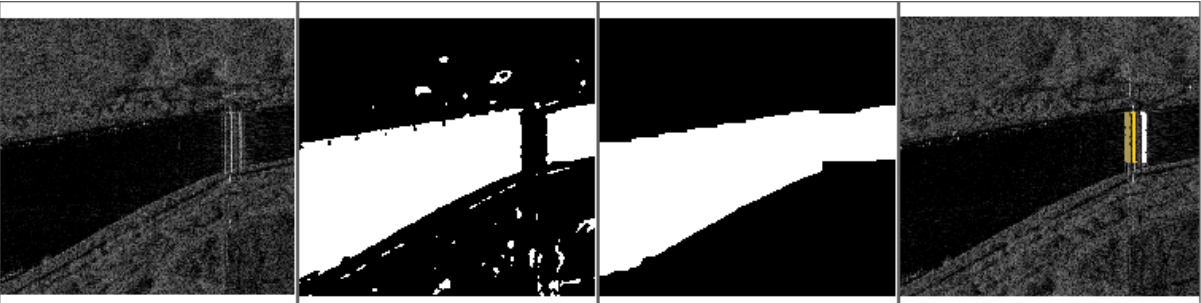
Figure 6. From left to right: amplitude SAR image, potential water surfaces (bright areas), morphologic filtering results in better water extraction, and detection of bridge crossing the